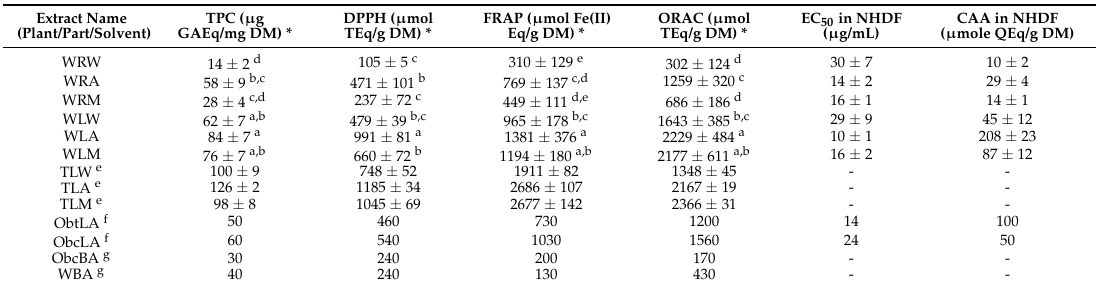
Table 1. Antioxidant activity and total phenolic content (TPC) of root and leaflet extracts of Euterpe oleracea .